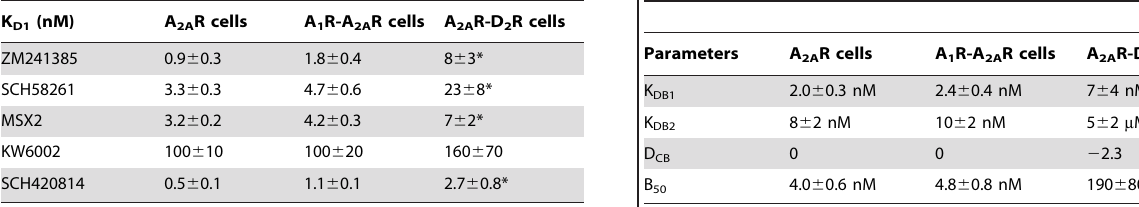
Table 3. Pharmacological parameters for A 2A R antagonist